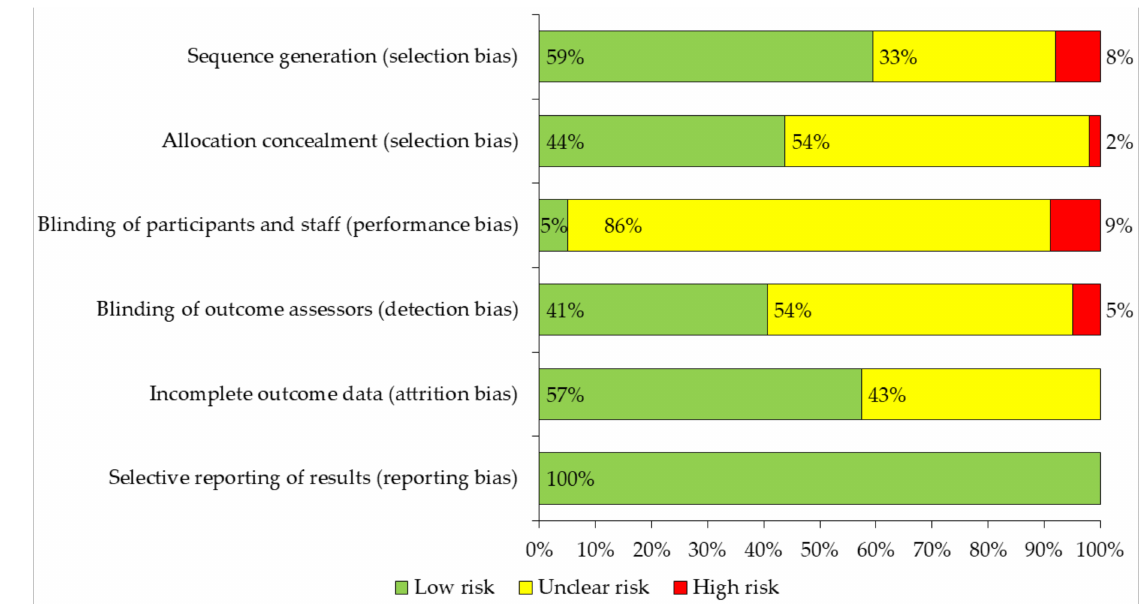
Figure 2. Evaluation of the methodological quality of the reviewed